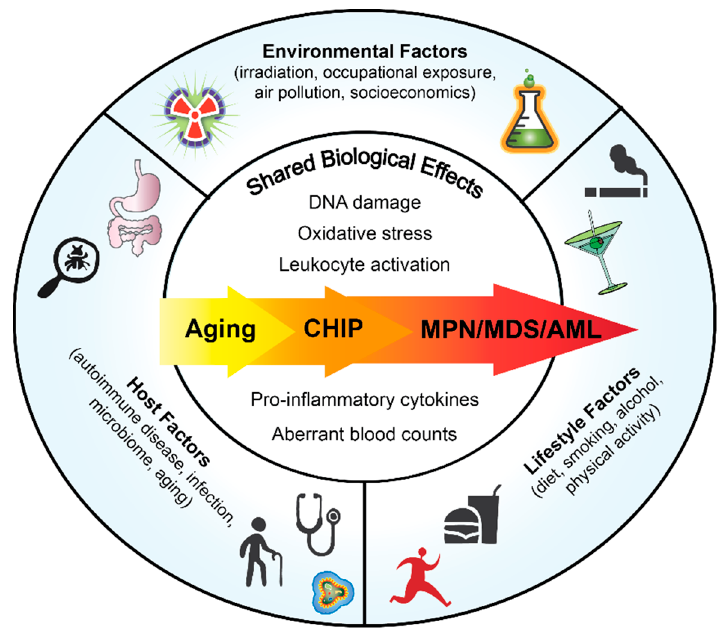
Figure 1. Overview of Factors that Could Impact Normal and Malignant Hematopoiesis.